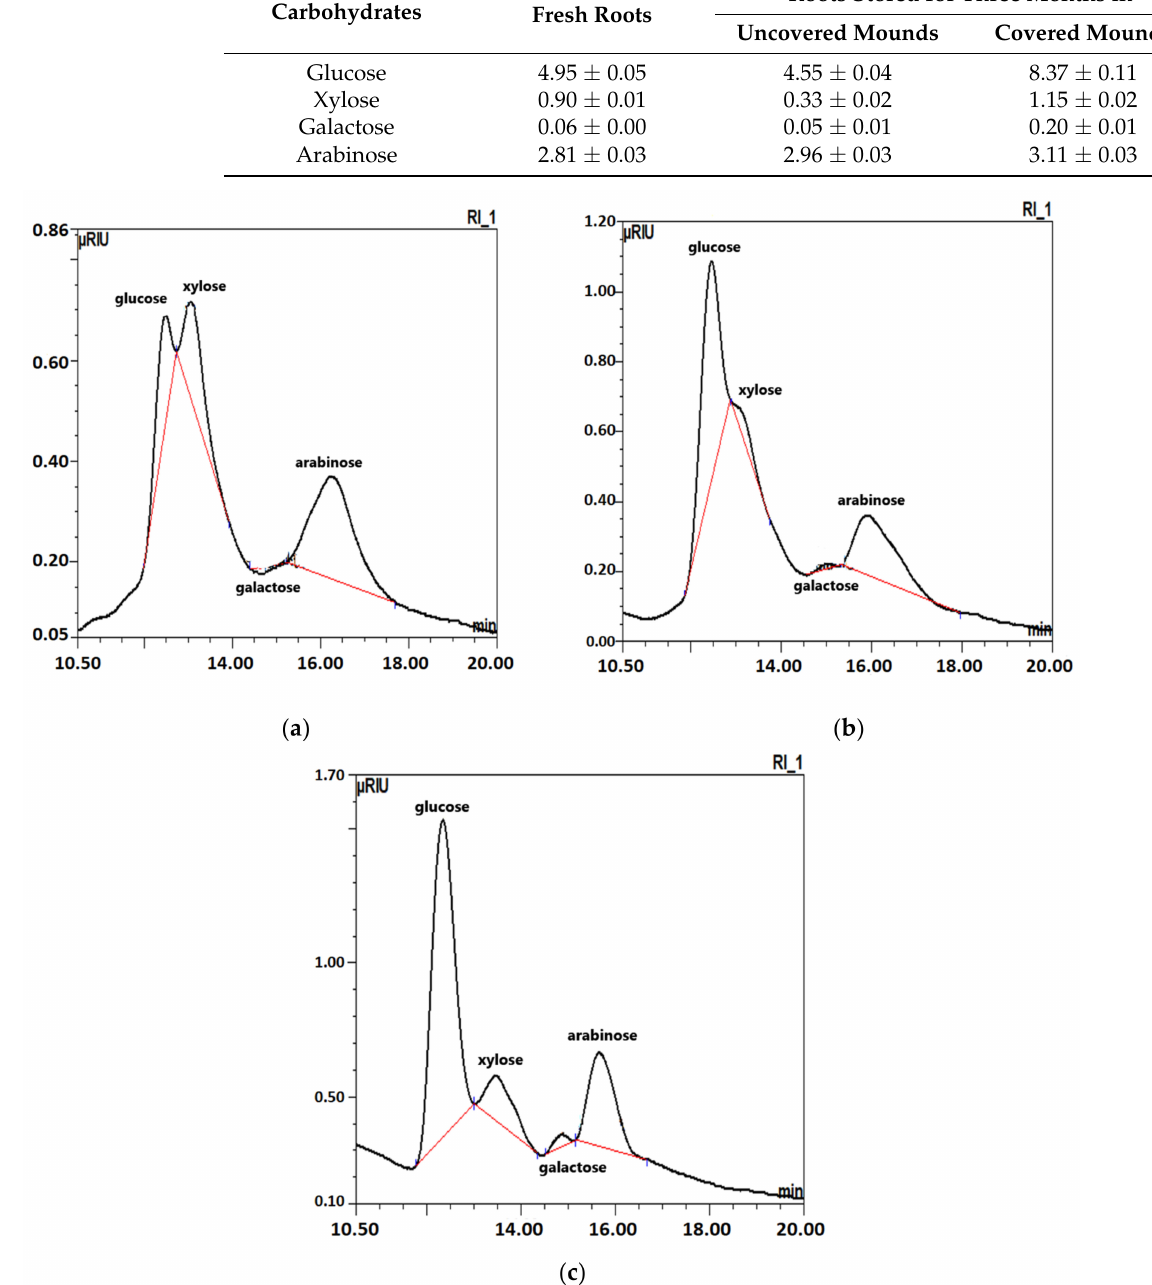
Figure 2. HPLC chromatograms of the profile of free sugars after the hydrolysis of complex carbohy- drates of sugar beet roots: ( a ) fresh roots; ( b ) roots stored in uncovered mounds (beet clamps) for three months; ( c ) roots stored for three months in covered (rain and snow-proof)